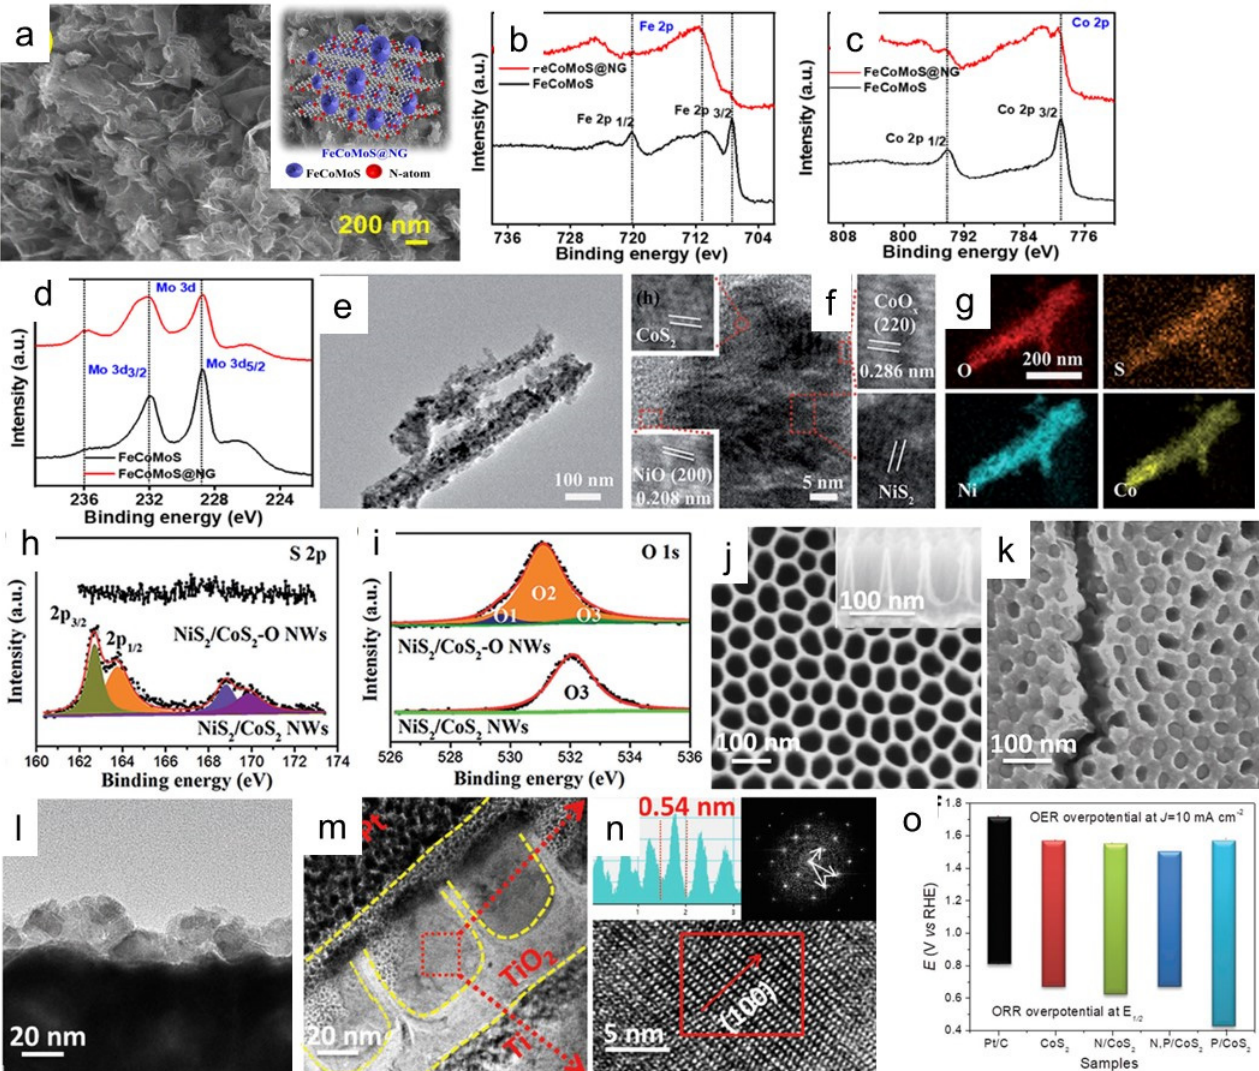
Figure 6. Structural characterization and electrochemical performance of typical chalcogenides. ( a ) SEM image of FeCoMoS@NG nanohybrid. ( b – d ) Comparative XPS spectra of ( b ) Fe 2p, ( c ) Co 2p, and ( d ) Mo 3d of FeCoMoS and FeCoMoS@NG. Reproduced from [112], copyright 2020, Elsevier. ( e – g ) TEM and HRTEM images and element mapping of NiS 2 /CoS 2 –O NWs. ( h , i ) XPS spectra of S 2p and O 1s of NiS 2 /CoS 2 NWs and NiS 2 /CoS 2 –O NWs. Reproduced from [117], copyright 2017, Wiley-VCH Verlag GmbH & Co. ( j , k ) SEM images of pristine TiO 2 nanoporous film (inset shows cross-sectional SEM view) and N, P/CoS 2 @TiO 2 , respectively. ( l , m ) TEM images and ( n ) HRTEM images of N, P/CoS 2 @TiO 2 with lattice spacing and fast Fourier transform (FFT) patterns inserted. ( o ) ORR and OER overpotentials of samples ( ∆ E = E j=10 − E 1/2 ). Reproduced from [118], copyright 2018, Wiley-VCH Verlag GmbH &